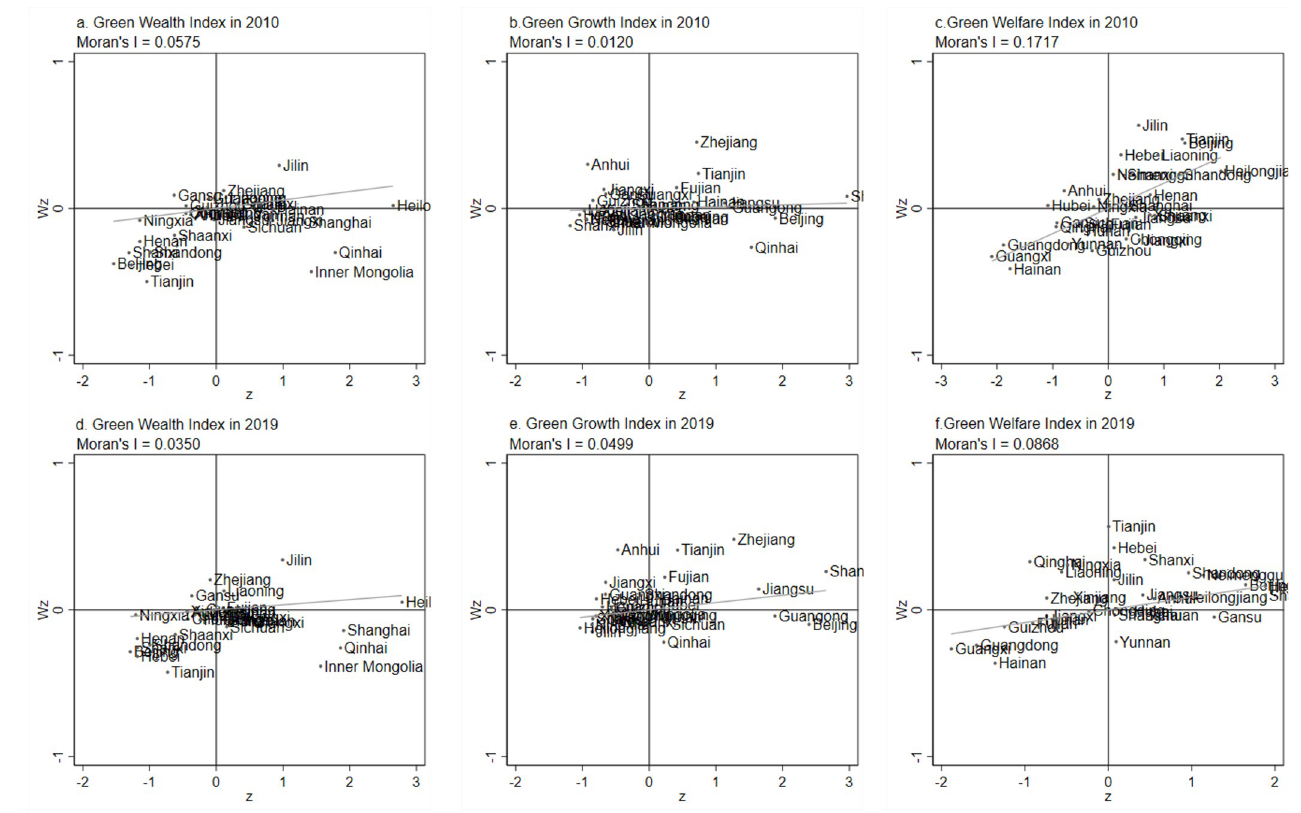
Fig 6. Local Moran’s I index scatter plot of China’s green-development component index from 2000 to 2019.